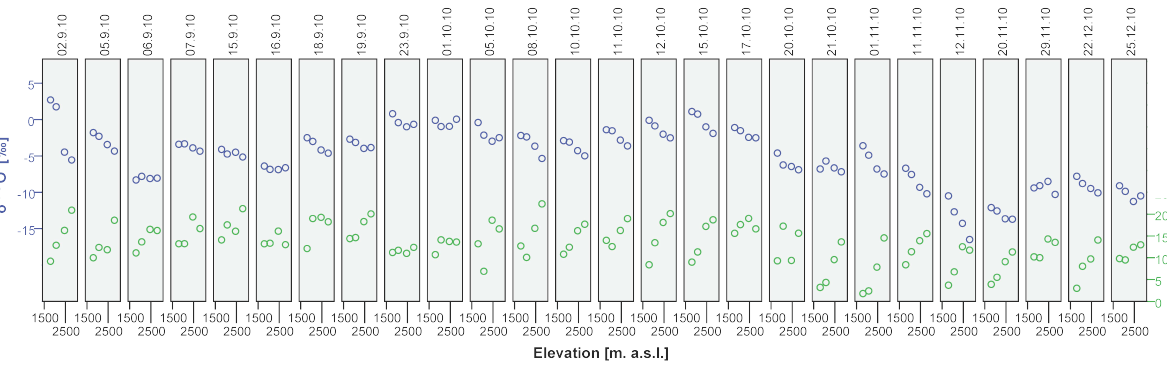
Fig. 3. Altitude effect and temporal variation of δ 18 O isotope signature and the deuterium excess in precipitation.